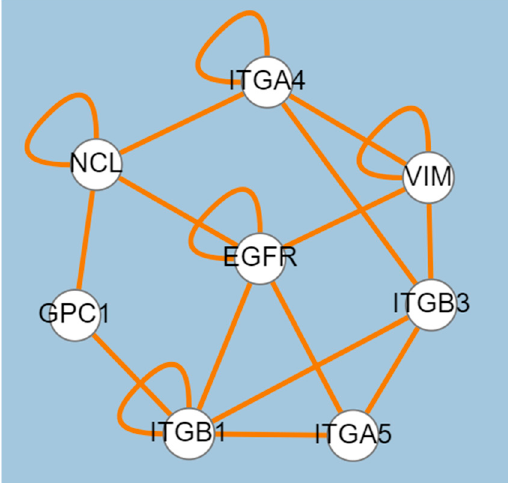
Figure 3. Group II phospholipase receptors or co-receptors have a direct physical interaction with each other, suggesting their involvement in multi-molecular complexes on the cell surface. Figure obtained via EsyN, using high and low throughput data from the Biogrid database [73]. The orange lines represent physical interaction between proteins Because of interaction with the surface receptors described above, sPLA2s are inter- nalized and transported to the paranuclear, or in some cases, even nuclear zones [24,66,74]. The intracellular function of sPLA2s is still poorly understood, but based on the intracellular interactions they establish, it can be assumed that they participate in protein complexes that are formed to produce lipid derivatives, such as prostaglandins and